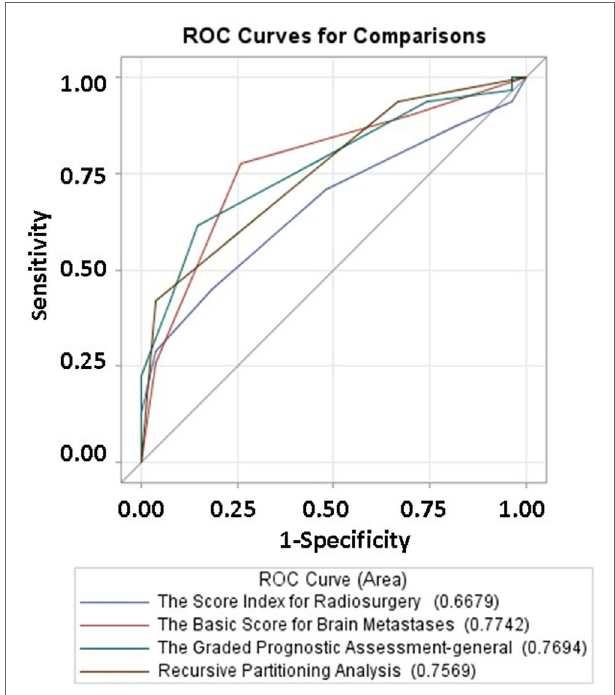
FigUre 2 | area under rOc curves for sir, rPa, BsBM, and gPa